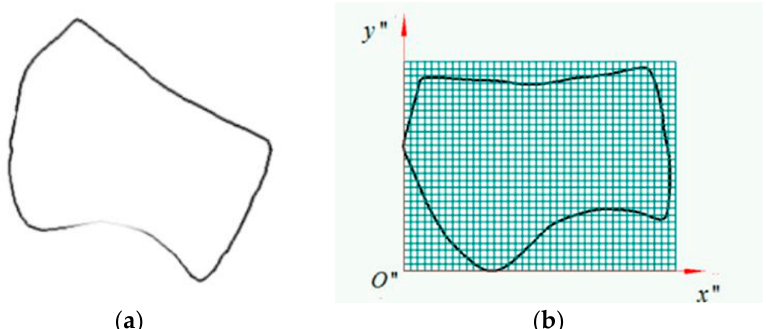
Figure 3. The rasterization processes. ( a ) Before the map is rasterized and ( b ) after the map is rasterized.